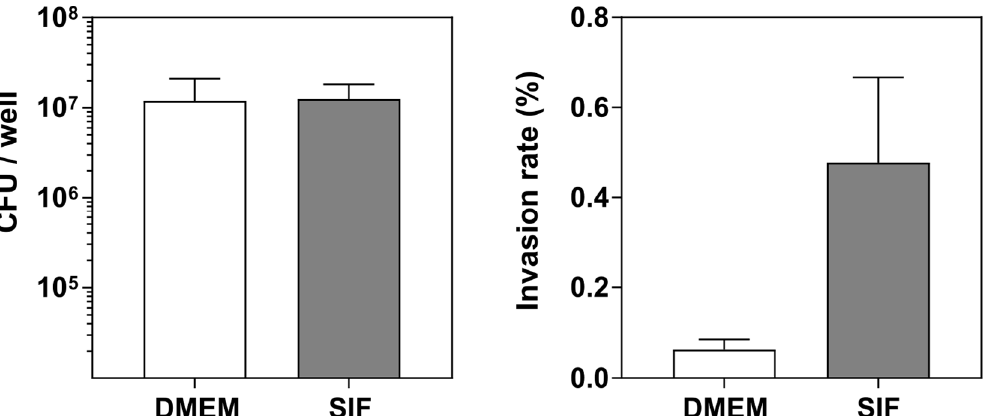
Figure 5. Simulated intestinal fluid. Quantification of the adhered (left panel) and invaded (right panel) bacteria to the 3D co-culture model infected with the pathogenic E. coli LF82 for 3 h after on overnight incubation with DMEM (white bars) or simulated intestinal fluid (SIF, grey bars). Mean ± SEM of two independent experiments with 3 replicates.